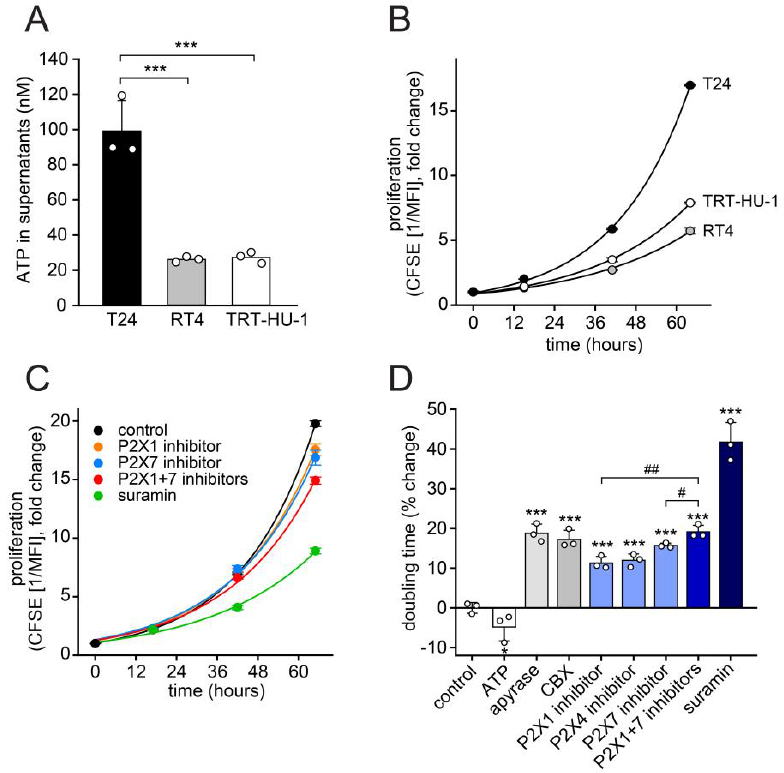
Figure 1. Extracellular ATP promotes proliferation of T24 cells through P2X receptors. ( A ) ATP concentrations in supernatants of T24, RT4, and TRT-HU-1 cell cultures were determined by HPLC (mean ± SD, n = 3 separate experiments; *** p < 0.001, one-way ANOVA). ( B ) T24, TRT-HU-1, and RT4 cells were labeled with CFSE and proliferation was determined at the indicated time points by flow cytometry (mean ± SD, n = 3 separate experiments). ( C ) T24 cells were treated with inhibitors of P2X1 (NF023; 10 µM) and/or P2X7 (A438079; 10 µM) receptors or with the general P2 receptor antagonist suramin (100 µM) and proliferation was assessed at the indicated time points (mean ± SD, n = 3 separate experiments). ( D ) Doubling times of T24 cells treated with P2 receptor inhibitors as in C or with ATP (10 µM), apyrase (1 U/ml), CBX (20 µM), or the P2X4R antagonist 5-BDBD (10 µM) were determined after 72 hours (mean ± SD, n = 3 separate experiments; * p < 0.05, *** p < 0.001